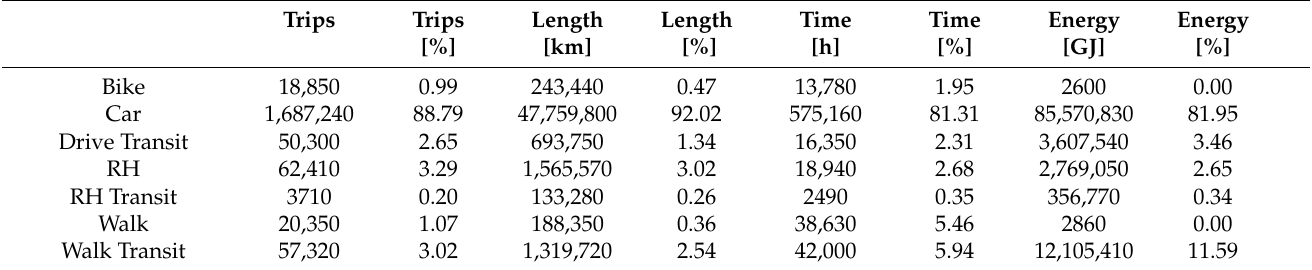
Table 1. Statistics of trips involving Santa Clara County in the baseline scenario per transport mode used—interfered to the population; RH = ride hail.